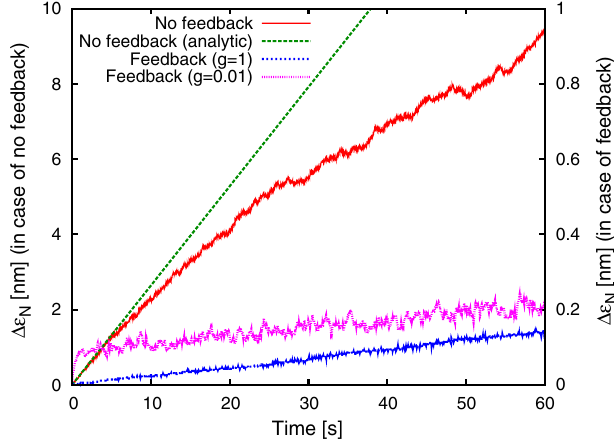
FIG. 3. (Color) Emittance growth caused by ground motion averaged over 100 machines. Observe that the left emittance scale applies when feedback is not used, and the right scale applies to the results obtained using feedback. Without feedback, the emittance quickly gets unacceptably large. During the first seconds, the emittance growth rate is in excellent agreement with the value ( 0 : 264 nm = s ) derived in Sec. III C 1. Since the emit- tance growth quickly becomes large, the second-order emittance approximation is however only accurate for a few seconds. By using feedback with gain g (cid:2) 1 , or even as low as g (cid:2) 0 : 01 , the emittance may be reasonably well